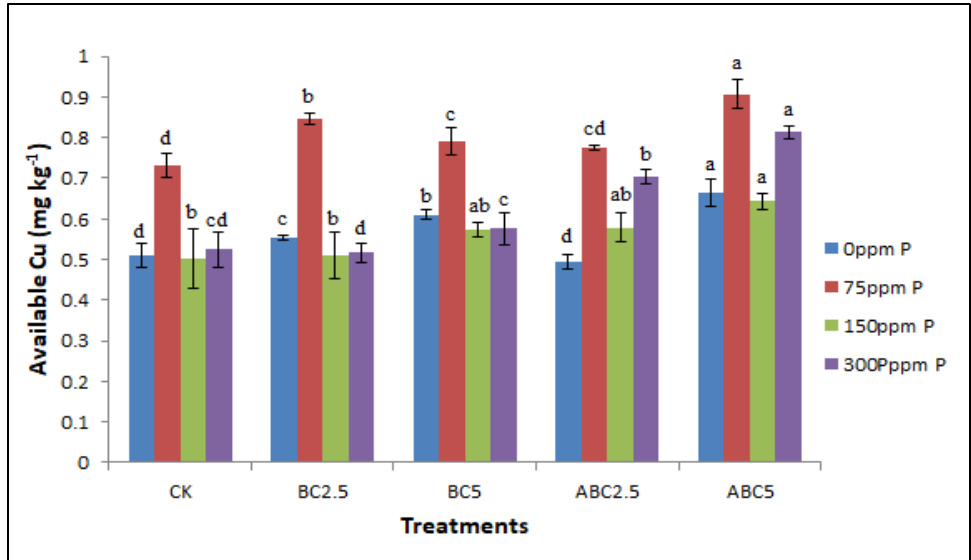
Figure 5. Effects of BC and ABC applied at different rates with different P fertilizer application rates on soil available Cu (mg kg − 1 ). Means with different letters within each fertilizer rate across each treatment indicate significant differences according to the least significant difference (LSD) test at p < 0.05. CK = Control, BC2.5 = Biochar added at 2.5% w / w , BC5 = Biochar added at 5% w / w , ABC2.5 =